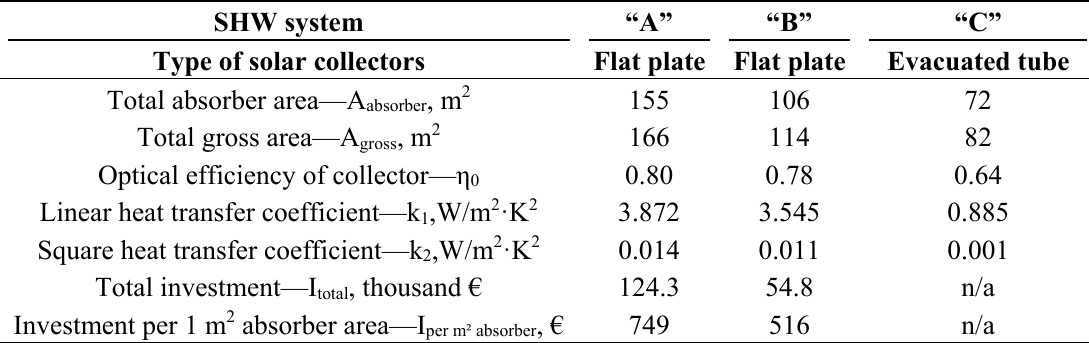
Table 5. Technical and economical characteristics of the analysed